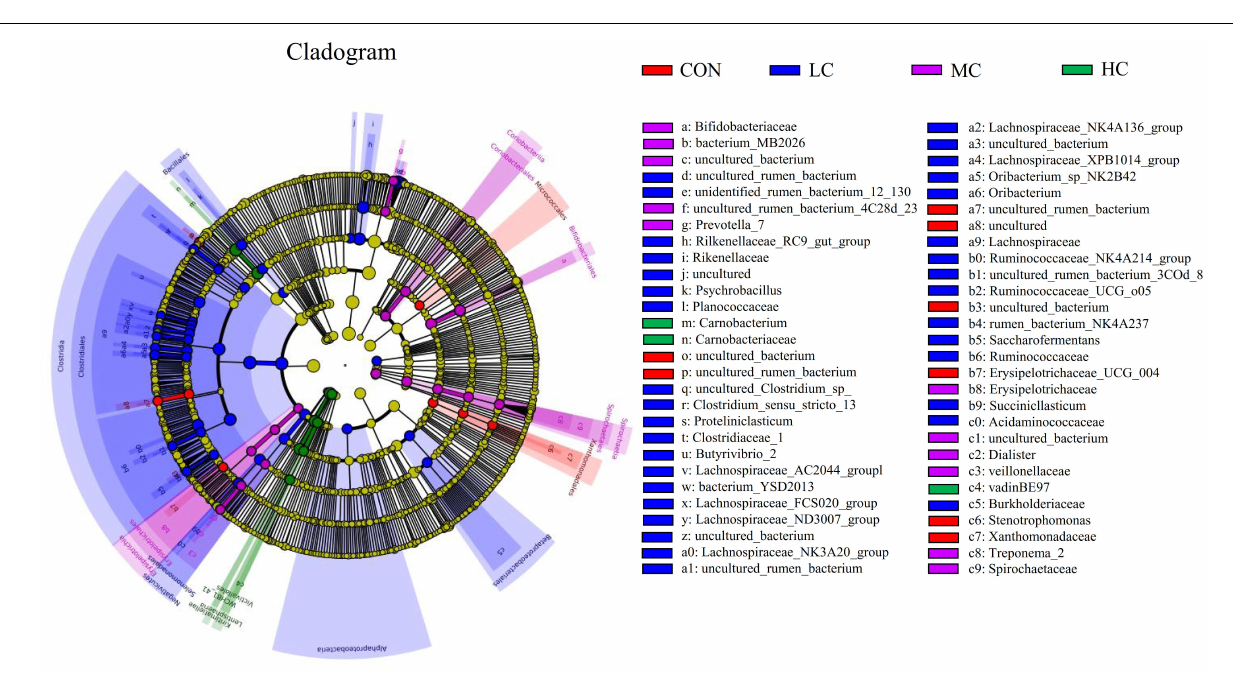
Frontiers in Microbiology |